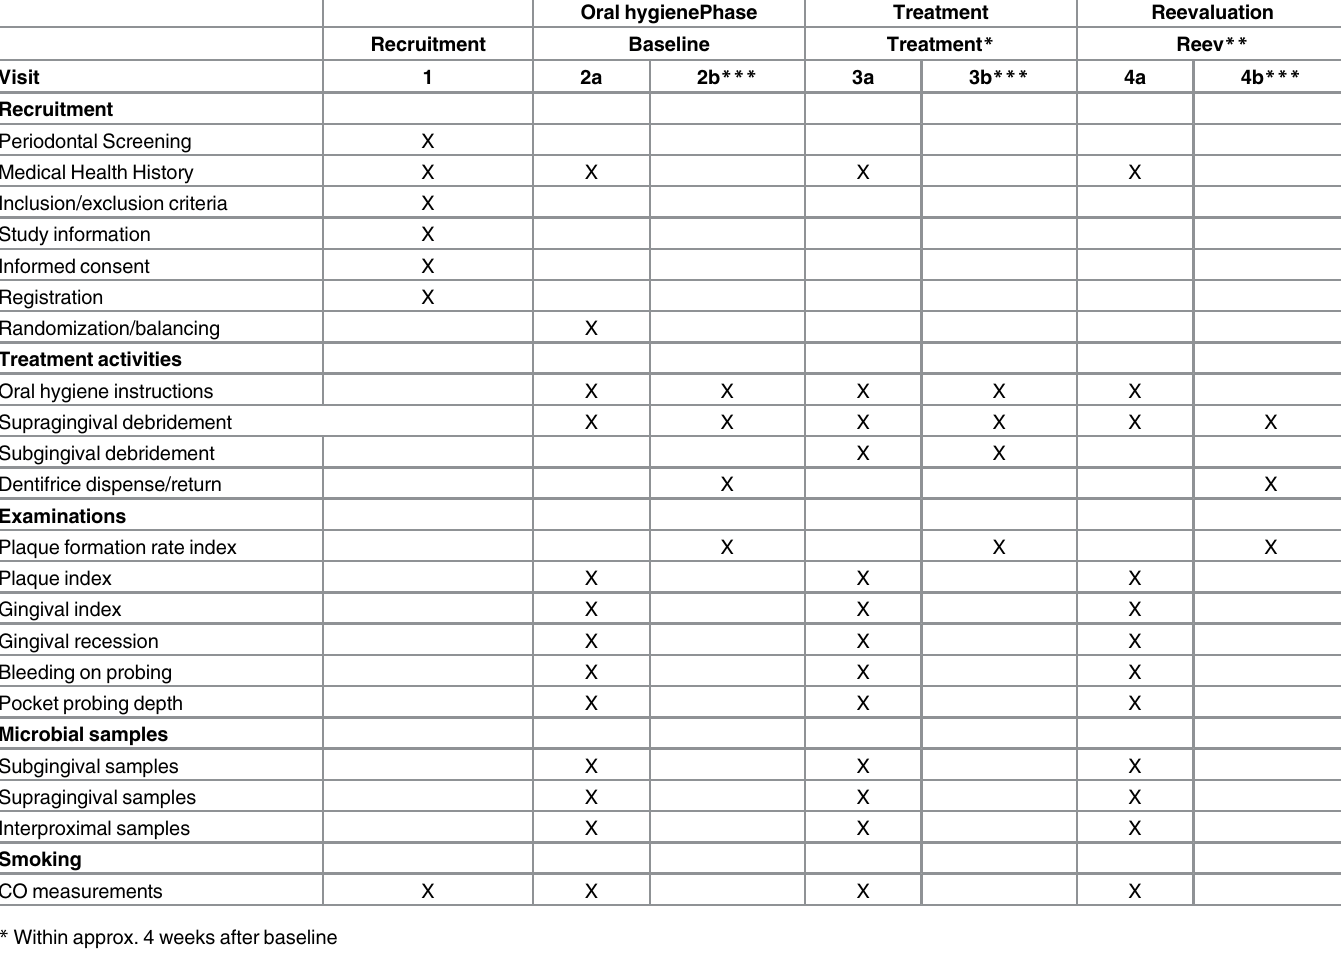
Table 1. Chronology of study visits, examinations, and